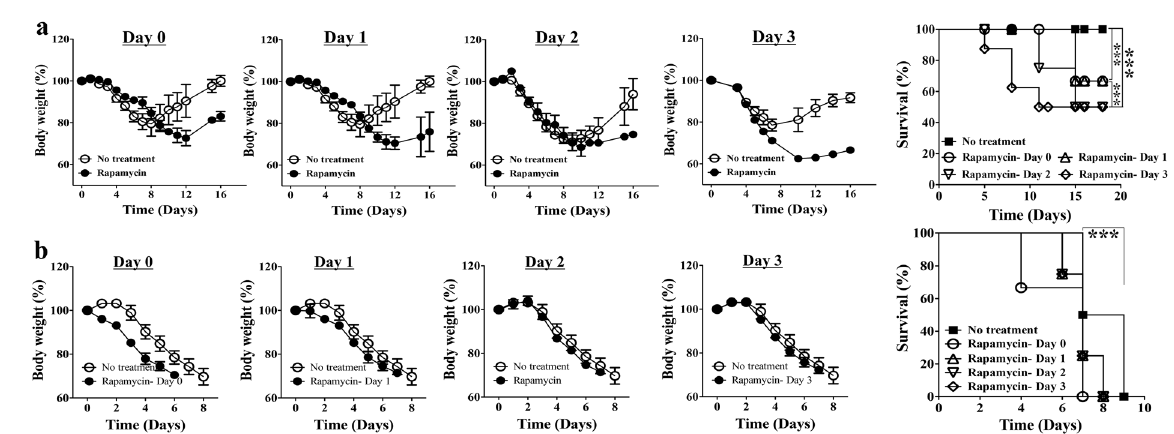
Figure 3. Rapamycin aggravates illness of both mild and severe disease regardless of timing of treatment. Aggravated disease with more bodyweight loss and higher mortality upon daily 3 mg/kg bodyweight Rapamycin treatment compared to that of untreated control BALB/c mice suffering from infection with either ( a ) 2.5 × 10 3 PFU or ( b ) 1.25 × 10 4 PFU PR8 influenza virus. Naïve mice of comparable age were infected with stated inoculum size of PR8 virus. Rapamycin treatment was started from the stated days post-infection and control untreated mice received equal volume placebo solvent as daily intraperitoneal injection. Data are representative of at least three similar experiments and presented as mean ± s.d. ( *** p < 0.0001; n =